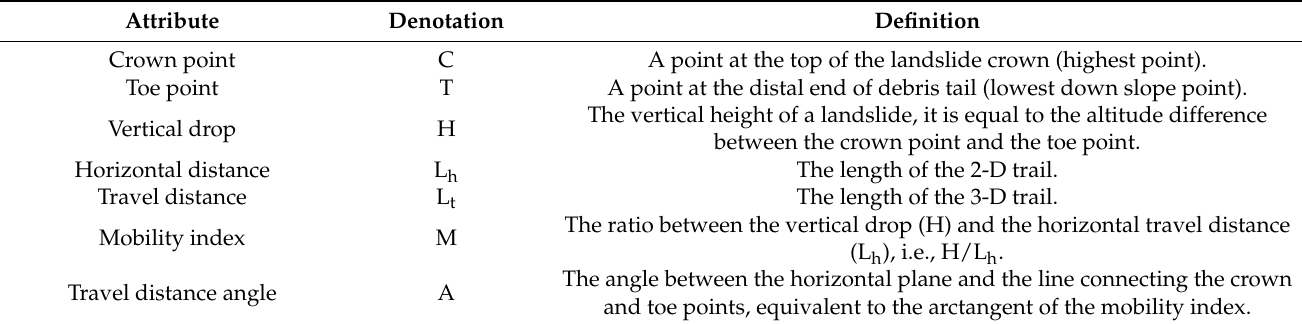
Table 1. Landslide characteristic parameters derived from the landslide